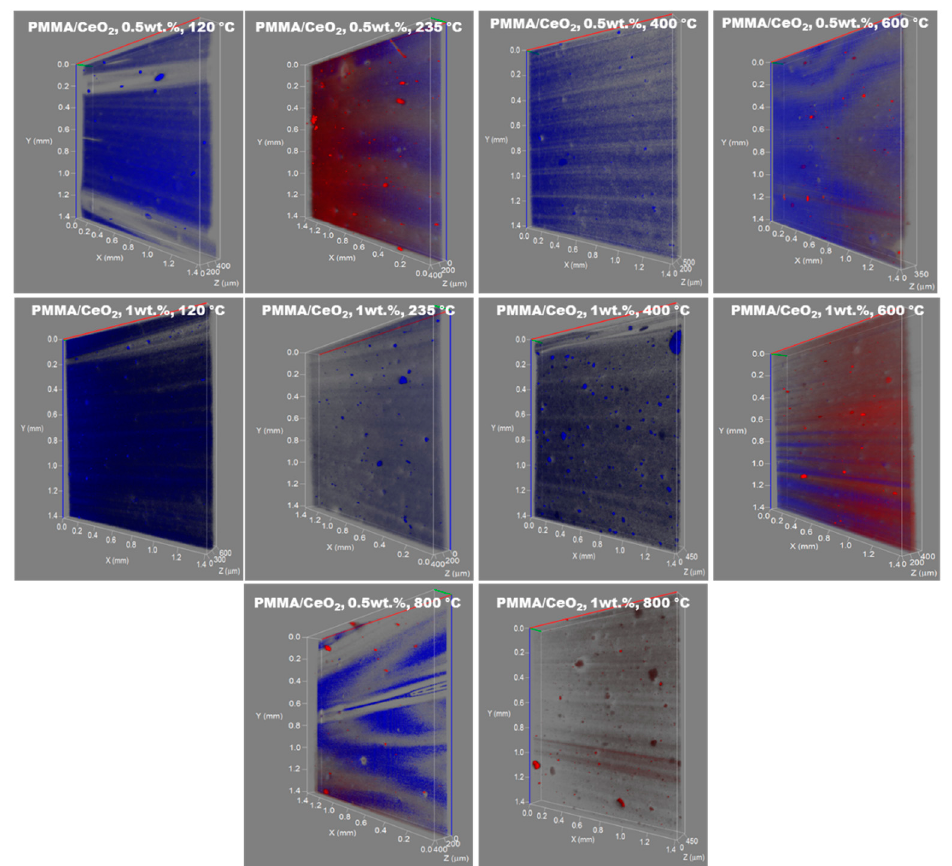
Figure 7. 3D CLSM representations of PMMA/CeO 2 hybrid systems.